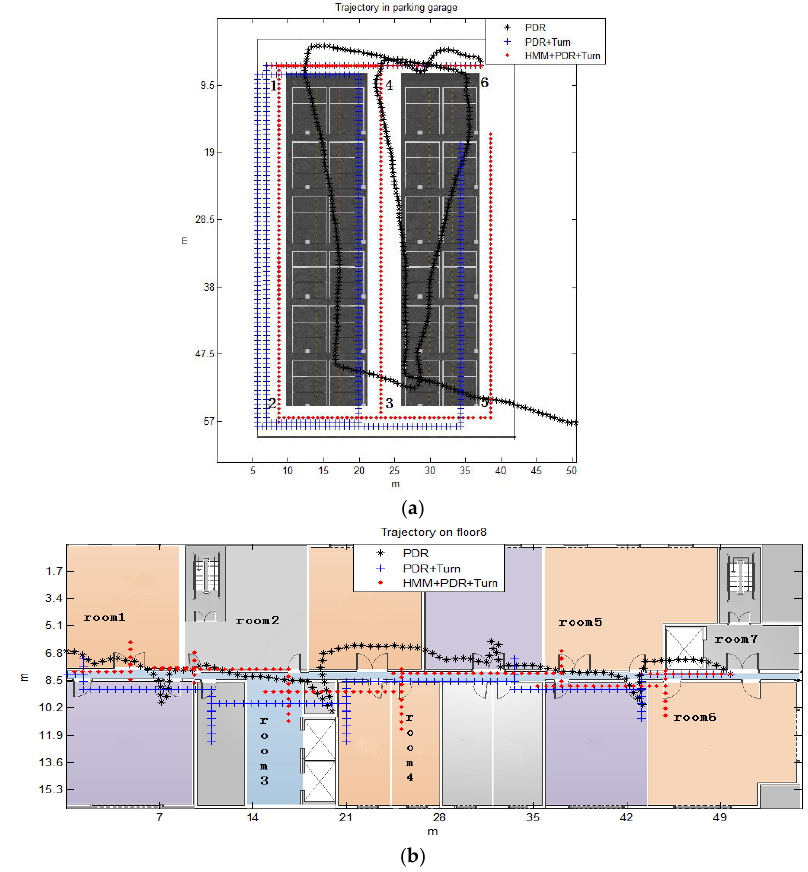
Figure 13. The trajectories of different algorithm. ( a ) In parking garage; ( b ) on the 8th floor.